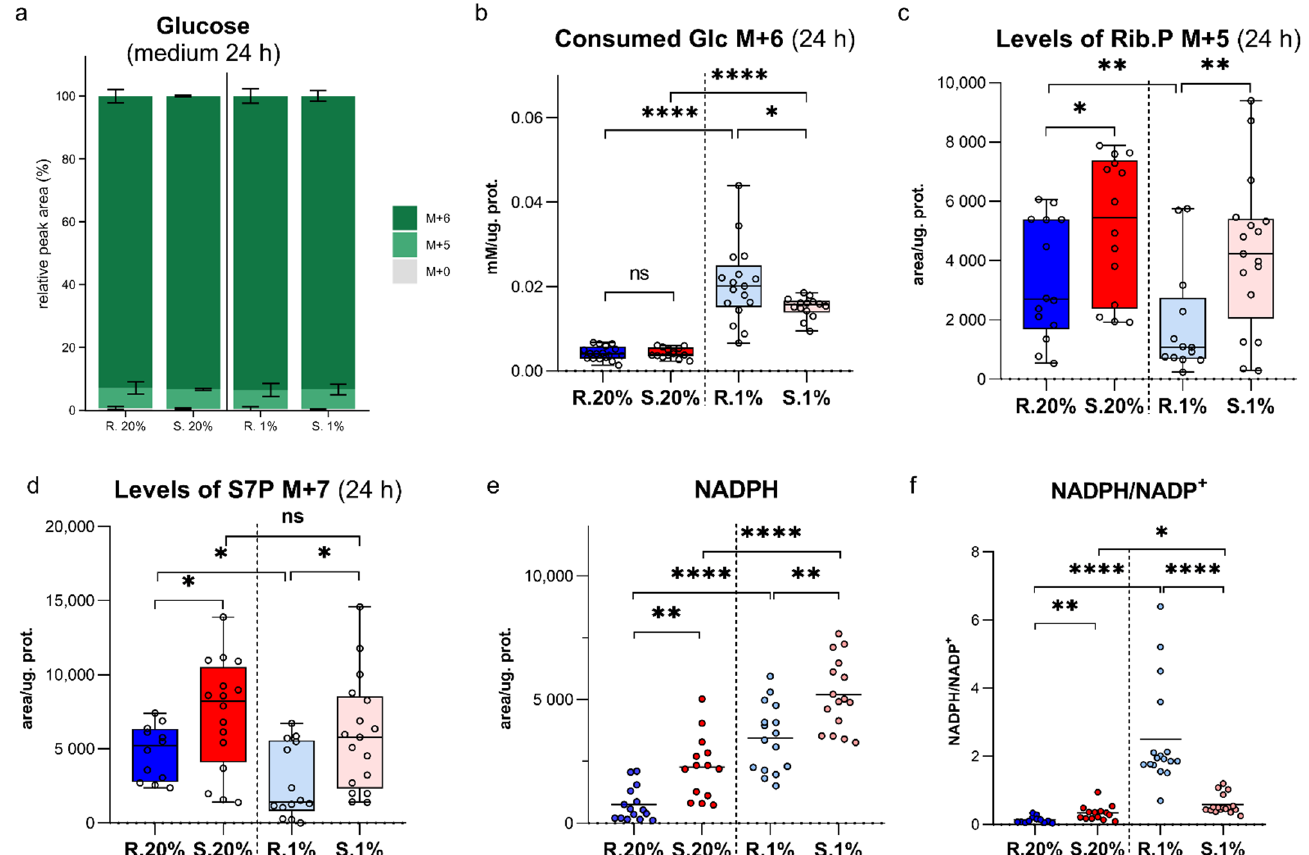
Figure 1. Mass isotopologue distribution (MID) for Glc in the culture media and consumption of Glc M + 6 by growing Spalax and rat cells. ( a ), Distribution of heavy carbons in culture media after 24 h; ( b ), the consumption of glucose by Spalax and rat cells under normoxia (20%) and hypoxia (1%); characteristics of the pentose phosphates pathway in normoxic and hypoxic Spalax and rat cells: ( c ), ribose phosphates (Rib.5P M + 5); ( d ), sedoheptulose-7-phosphate (S7P M + 7); ( e ), NADPH; ( f ), ratio of NADPH/NADP in Spalax and rat cells after 24 h of growing under normoxia and hypoxia. S.20%, R. 20%, S.1%, R1% represent Spalax (S) and rat (R) cells exposed to an atmosphere containing 20% or 1% O 2 , respectively; ns, (nonsignificant) p > 0.05; * p < 0.05; ** p < 0.01; **** p < 0.0001, error bars represent standard deviation of 6 or more biological repeats. Every point on the chart represents one technical repeat.